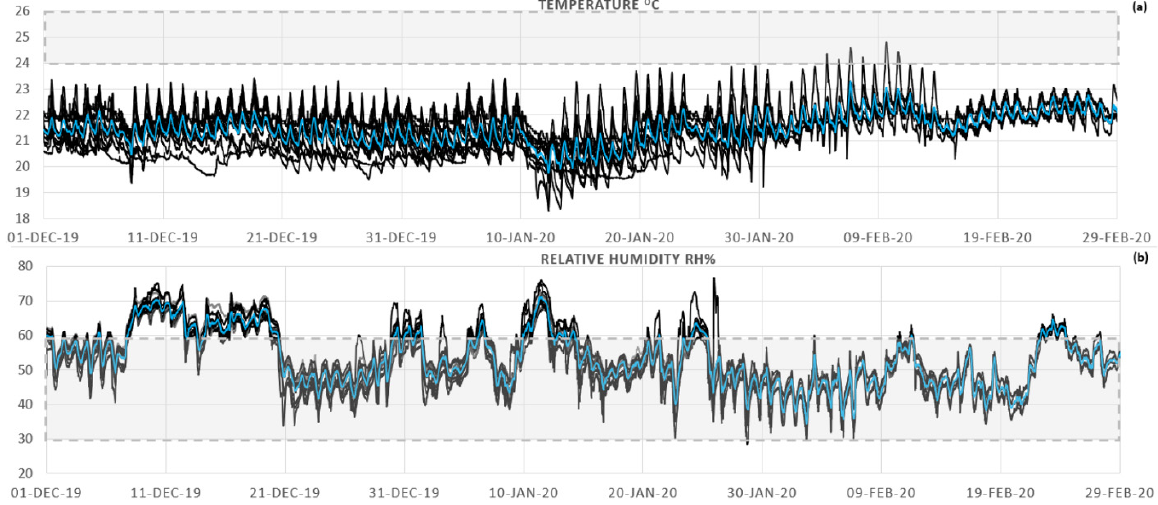
Figure 5. Temperature ( a ) and RH ( b ) December to February profiles. The blue line indicates average, and the grey box indicates recommended thresholds.